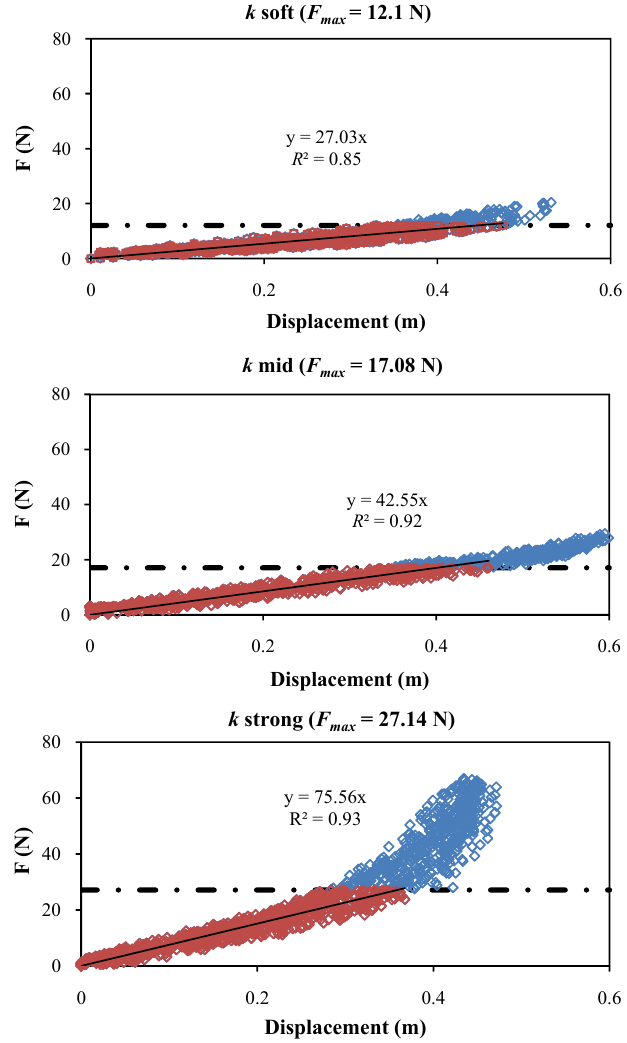
Figure 4. Calibration curves for the three springs used, in dynamic loading